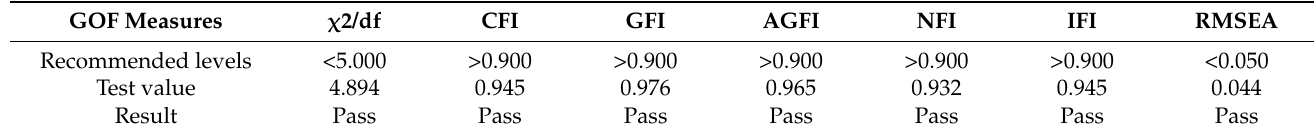
Table A3. Confirmatory factor analysis (CFA) of the discriminant validity.